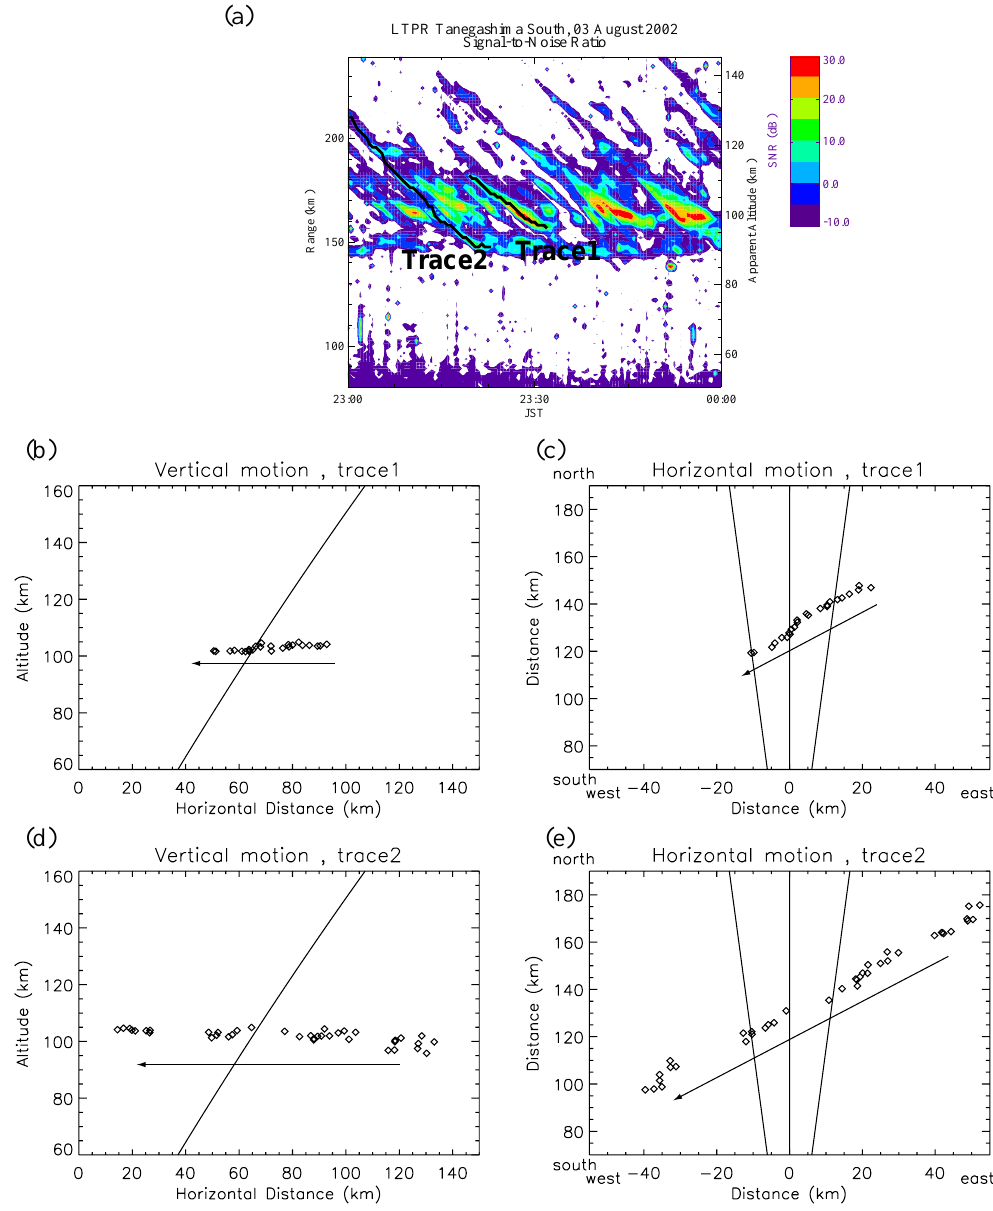
Fig. 8. (a) Echoes observed between 2300 and 2400 JST on 3 August 2002. Motion of echoes on Trace 1 in (a) is tracked in (b) the vertical and (c) horizontal planes. Solid line in (b) indicates the center of radar beam (Azimuth +30 ◦ ). Three solid lines in (c) indicates the center of radar beam and the directions of + 30 ± 5 ◦ . (d) and (e) are same as (b) and (c), except for Trace 2 in